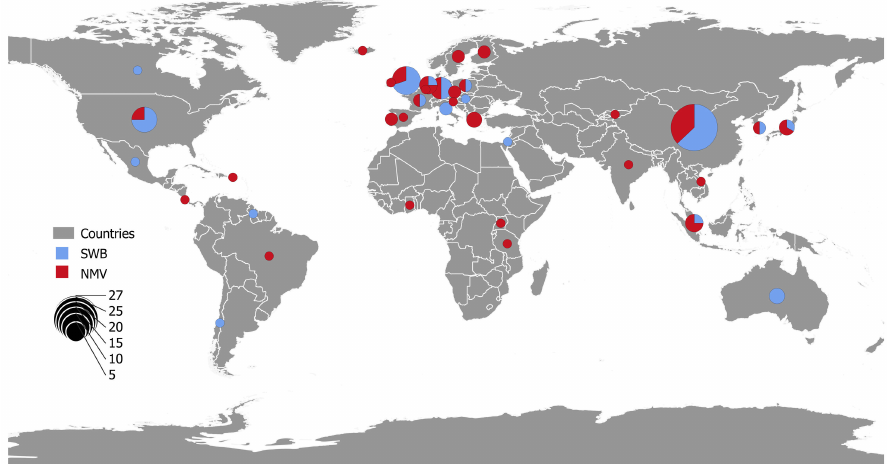
Figure 4. Geographical distribution of reviewed articles.